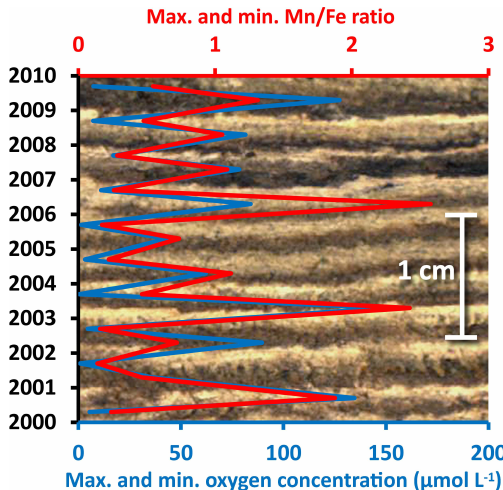
Fig. 16. Detail of the laminated sediment core from Lake Zurich covering the period 2000–2010. The profiles show seasonal changes in the Mn/Fe ratio (based on maximum and minimum XRF counts in the respective layers of the core, red line) and in the bottom-water oxygen concentration at 135m water depth (maxima and minima of a 3-month running mean of the monitoring data, blue